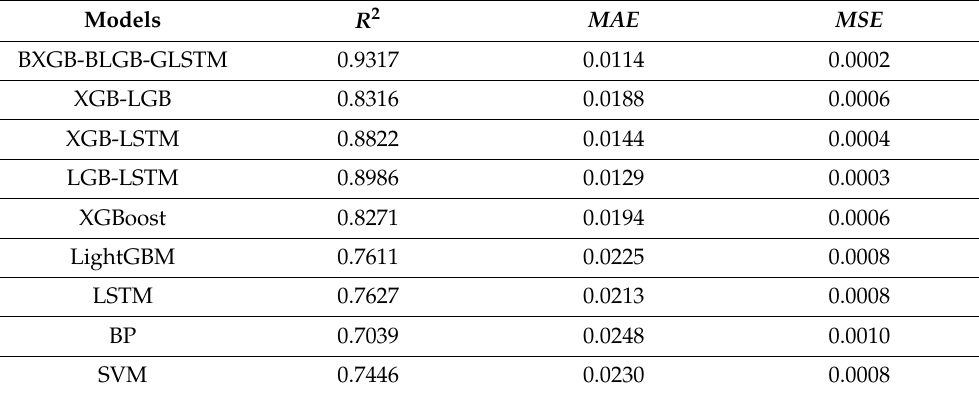
Table 5. Comparison of evaluation metrics by